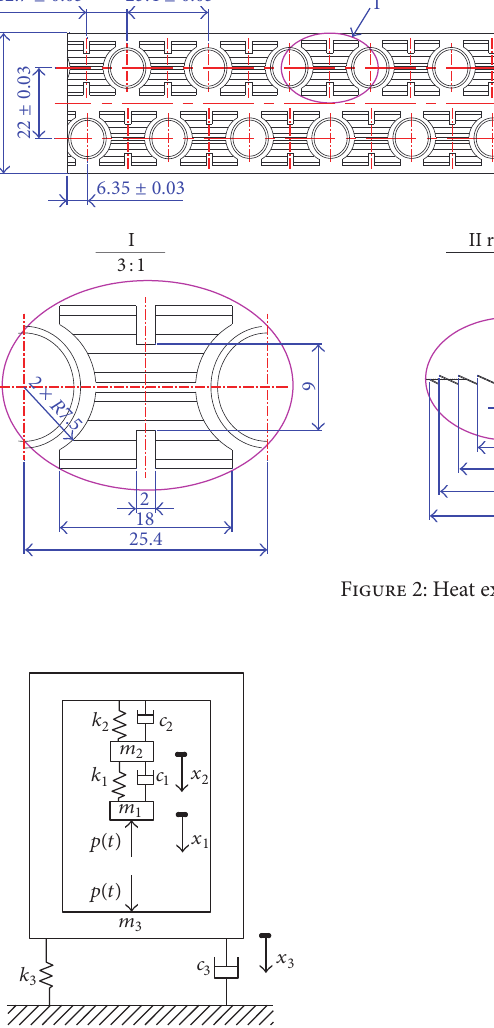
Figure 3: Three-DOF vibration model of a high-speed punching